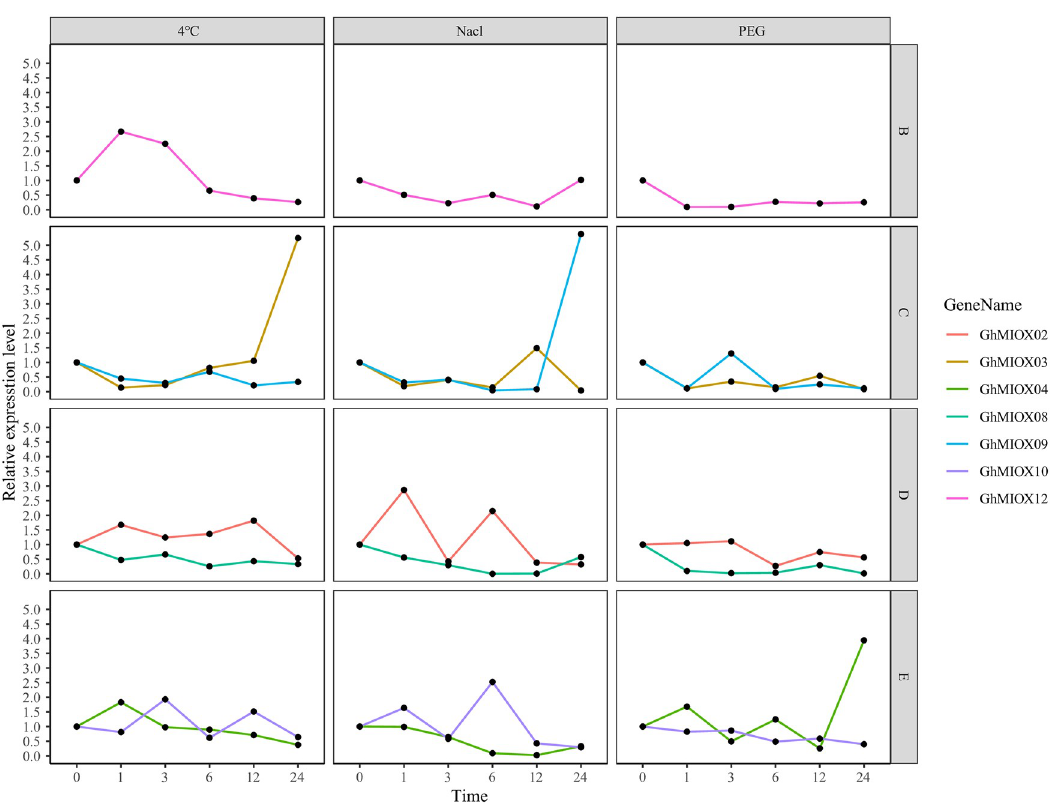
Fig 9. Expression of MIOX genes under different stress